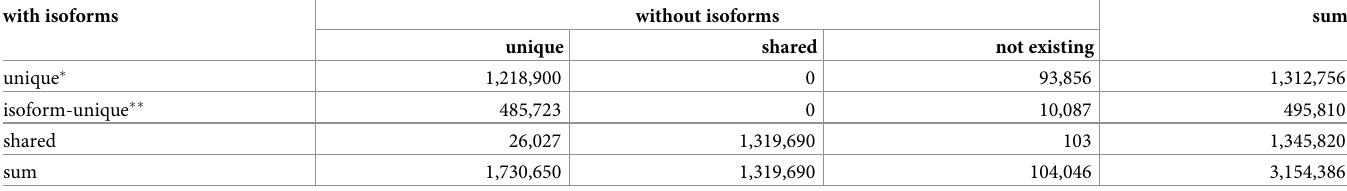
Table 2. Unique and shared peptides stemming from in silico digestion of D3_fasta and D3_iso_fasta (without and with isoforms). with isoforms